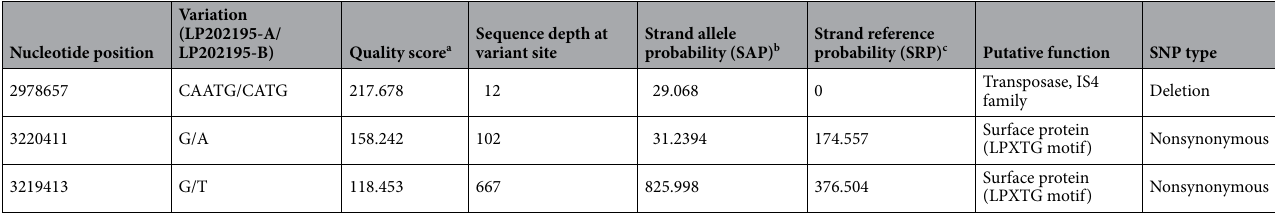
Table 2. Summary of single nucleotide variants between L. plantarum ATCC 202195-A and L. plantarum ATCC 202195 -B. a Based on an estimated probability that the alternate allele is present at the loci, as calculated using Freebayes 26 . b Strand balance probability for the alternate allele, as calculated using Freebayes 26 . c Strand balance probability for the reference genome, as calculated using Freebayes 26 .